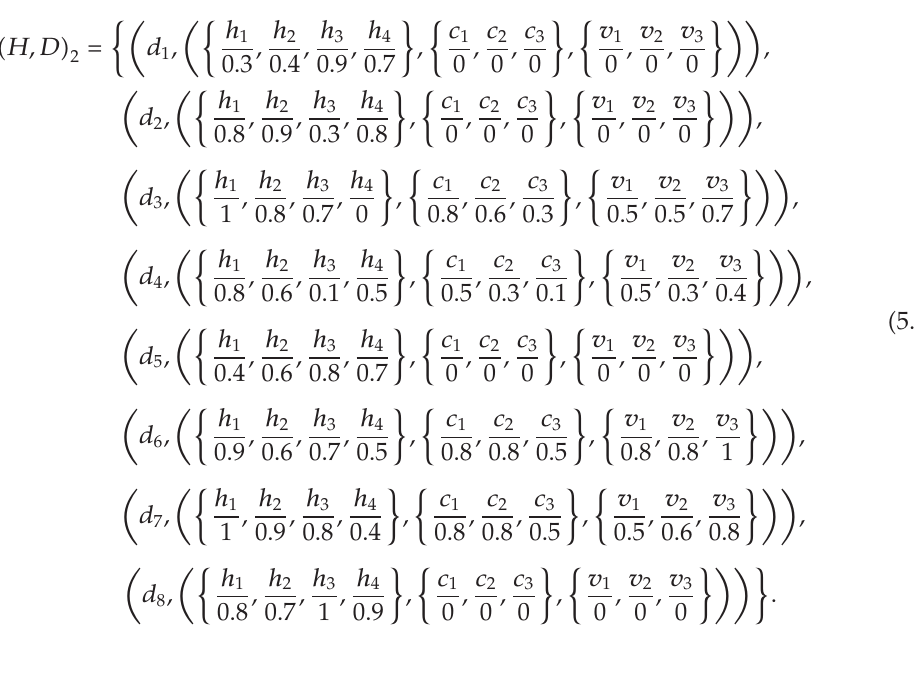
Table 5: Comparison table: U